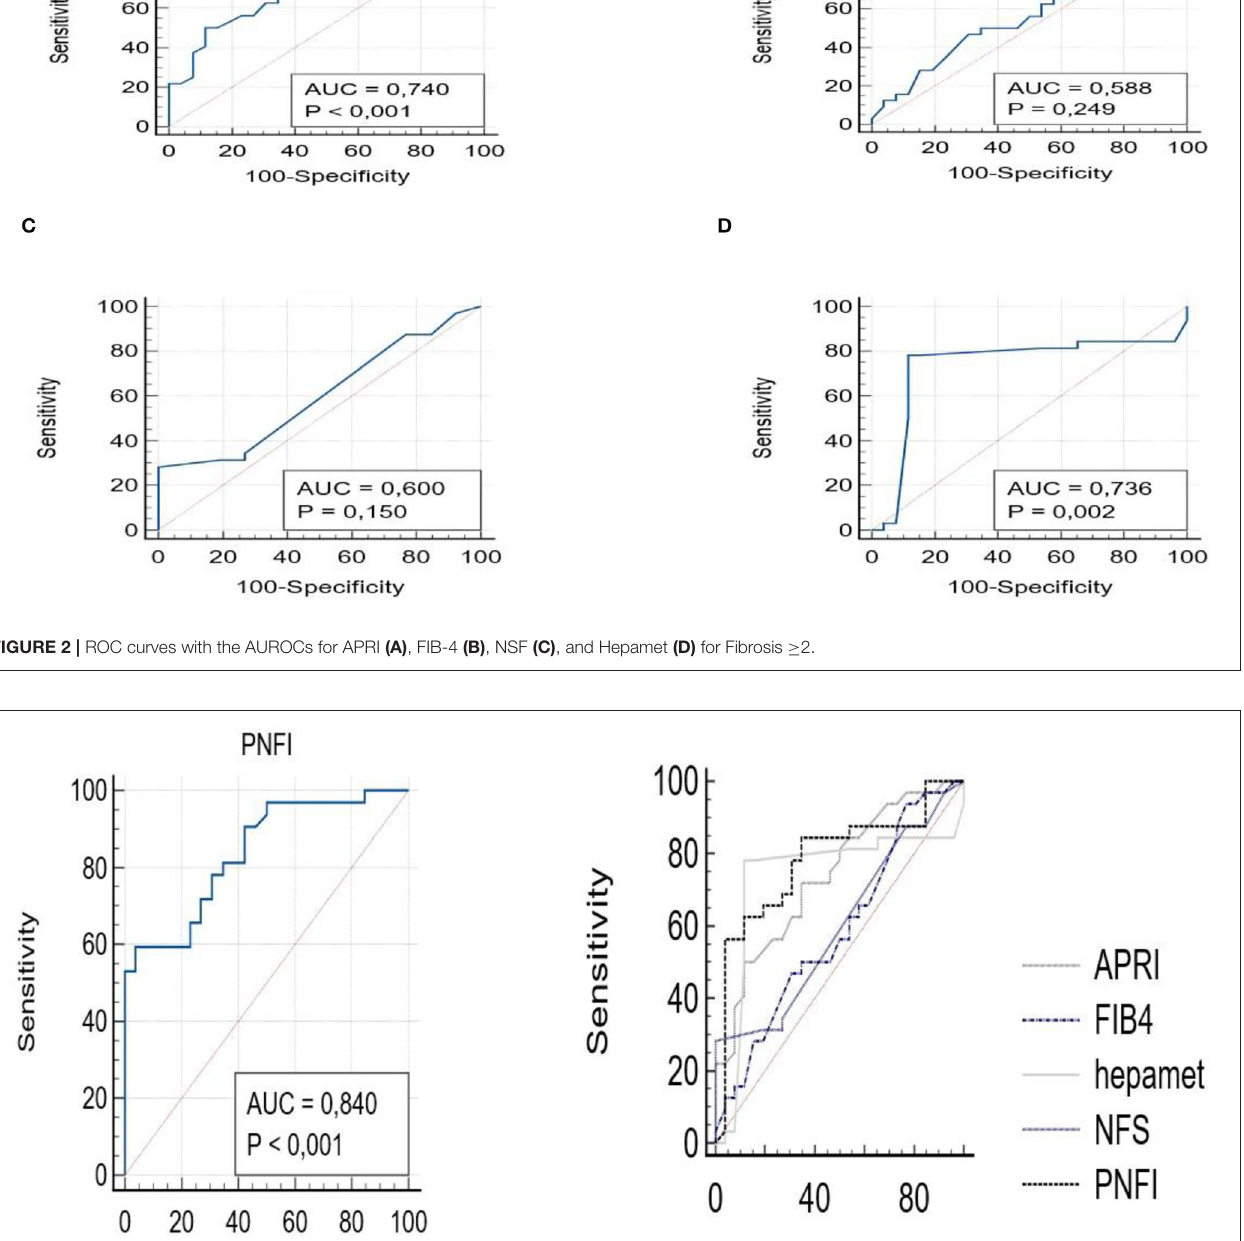
FIGURE 3 | Comparison between the ROC curves for all scores and PNFI.